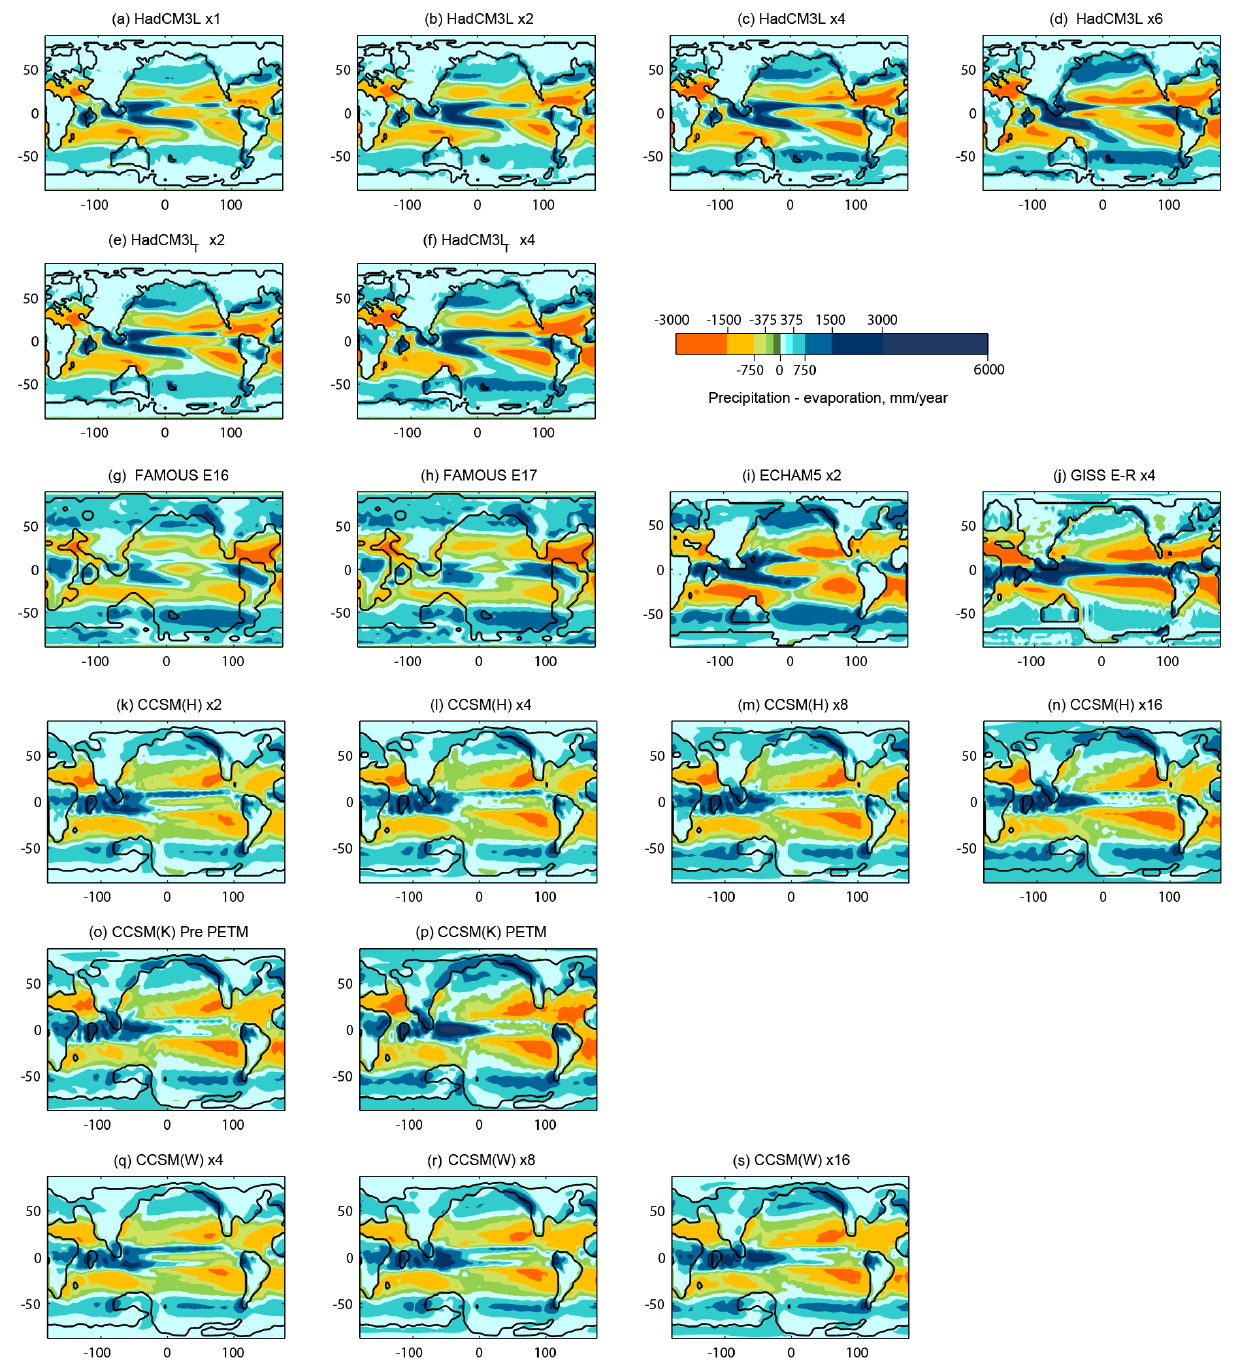
Figure 8. Mean annual P − E distributions for each member of the EoMIP ensemble in millimetres per year (early Eocene paleogeography). CO 2 for each model simulation is shown above each plot. The FAMOUS simulations are both at x2 preindustrial CO 2 .